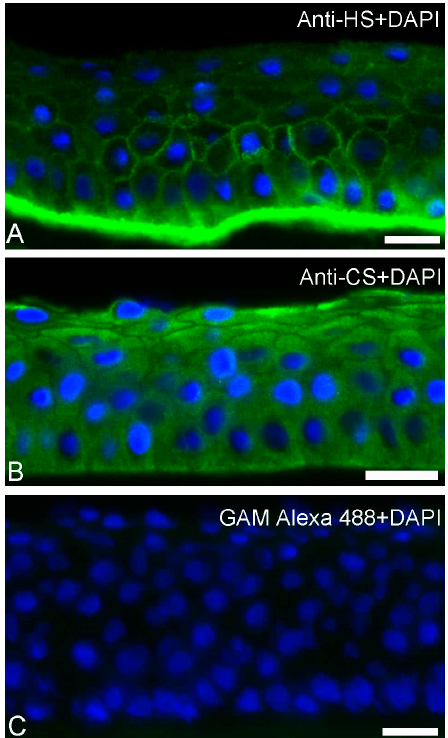
Figure 7. The presence of HS and CS on healthy human corneal epithelium tissue. Human corneal epithelium was labeled (green appearance) with antibodies to HS ( A ) and CS ( B ). The staining with only secondary antibody was used as a control ( C ). Nuclei were stained using DAPI (blue appearance). All bars represent 20 μ M.